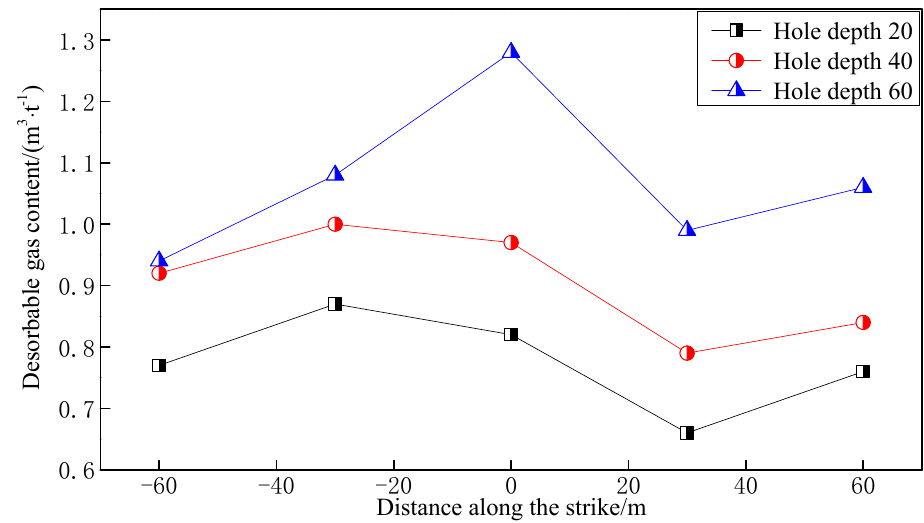
Figure 10. Variation law of gas content near Ma tan 31 abandoned oil well .